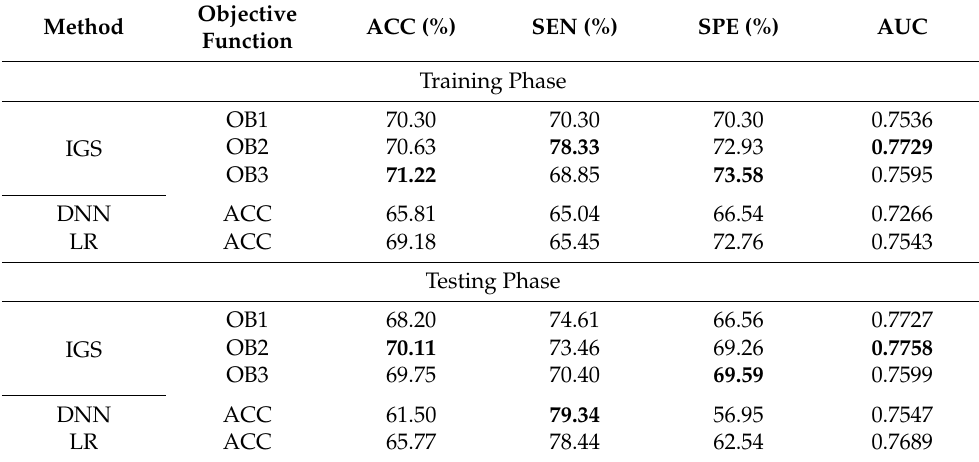
Table 5. Predictive performances of models designed by the IGS, DNN, and LR